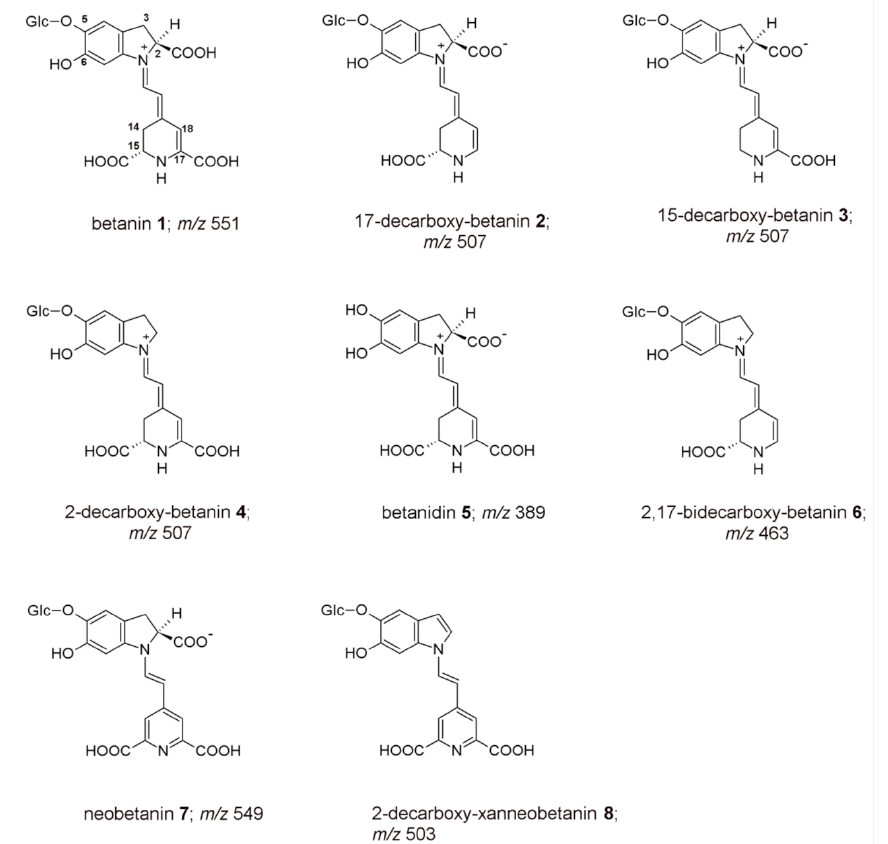
Figure 1. Chemical structures of betanin 1 , its derivatives ( 2 – 4 , 6 – 8 ), and betanidin 5 present in the BRE subjected to studies on chlorination and anti-hypochlorite activity in this contribution. Pigment 6 was tested together with its epimer 6 (cid:48) (Table